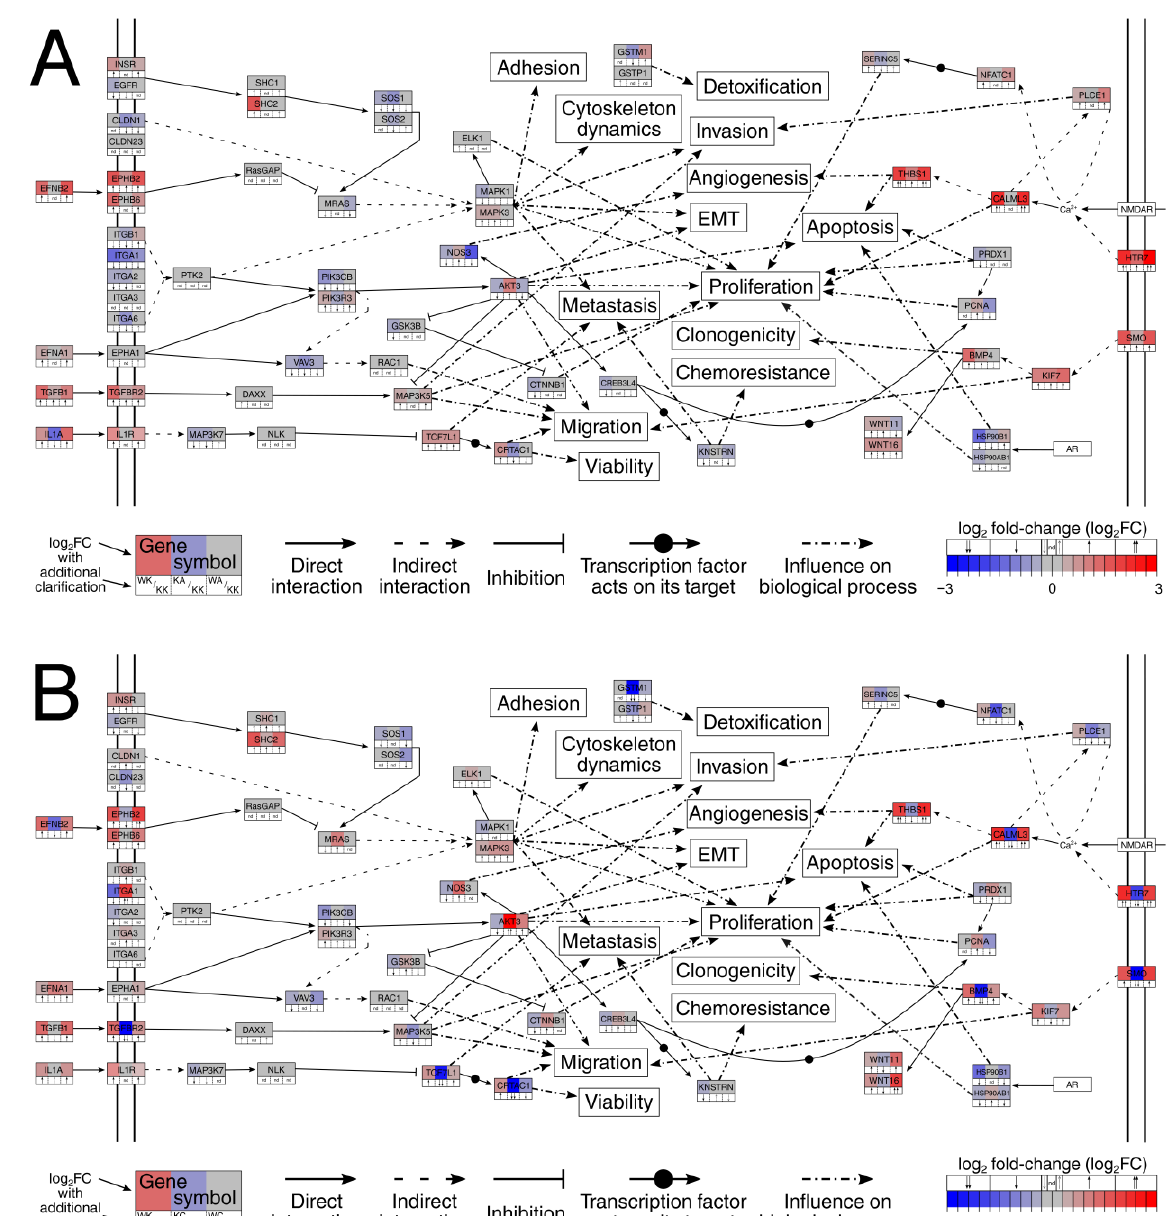
Figure 5. Differences and similarities between ( A ) ‘alpha’ and ( B ) ‘gamma’ comparisons regarding the signal transduction.